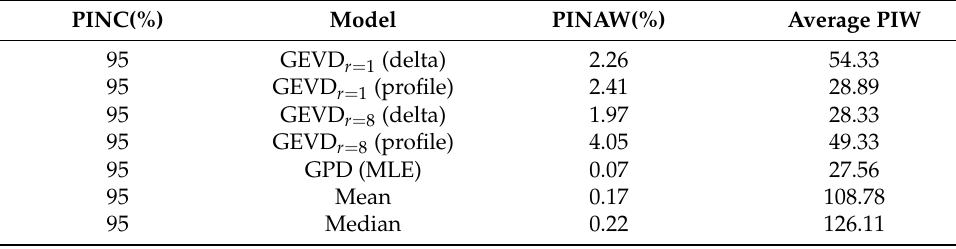
Table 5. Evaluation metrics for prediction